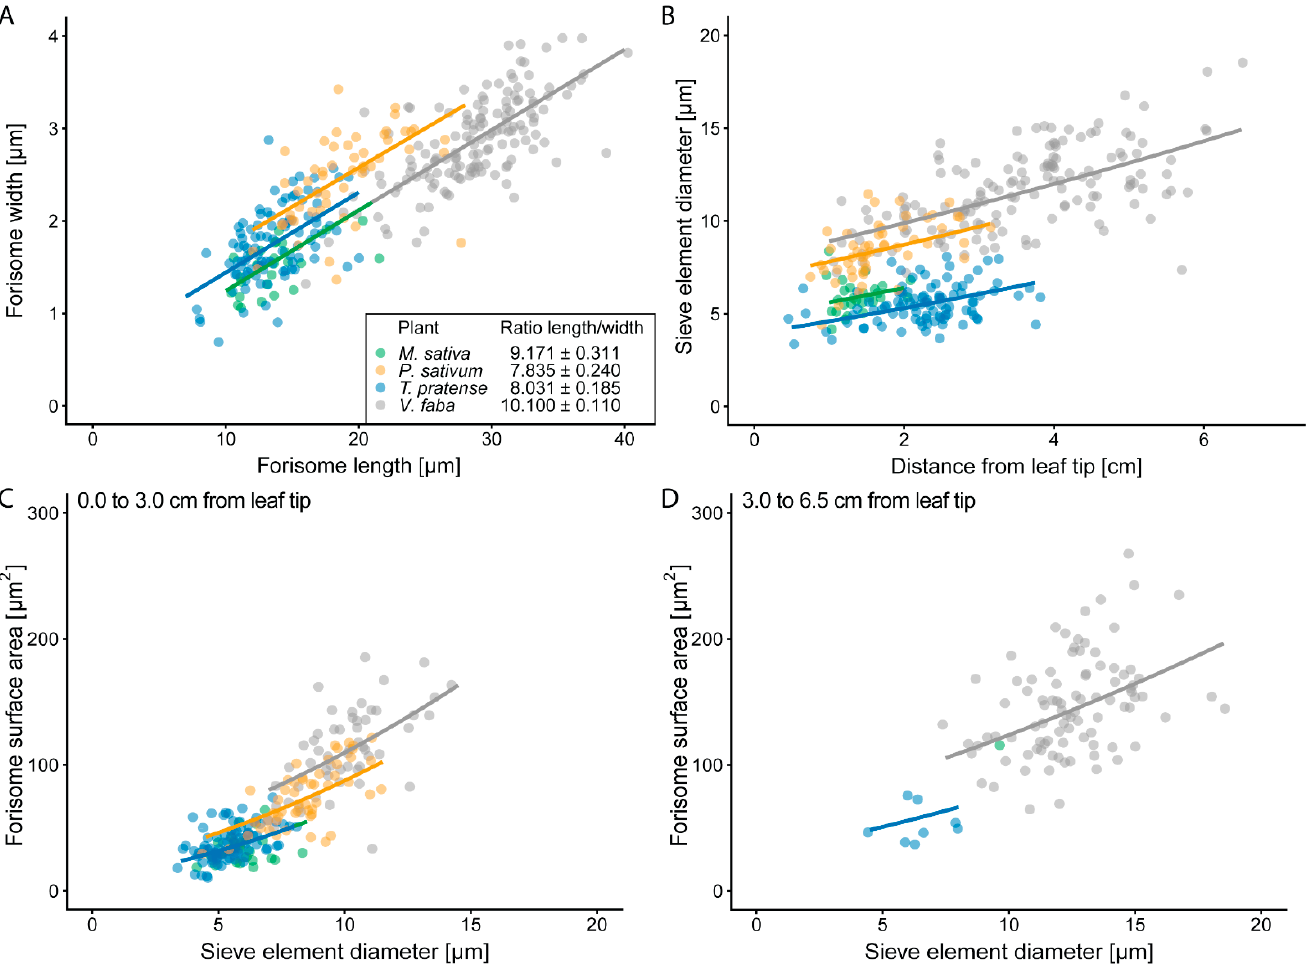
Figure 1. Relationships between sieve element (SE) diameter and forisome dimensions or distance from the leaf tip. ( A ) The relation between forisome width and forisome length and ( B ) between SE diameter and the distance from the leaf tip ( B ) is shown for the investigated legume species. The inset in ( A ) shows the ratio of forisome length to forisome width ± standard error as a numerical presentation of the graphs. ( C , D ) The forisome surface area ( A F ) was calculated based on the forisome width and length and related to the SE diameter. For a better graphical presentation, the relation between forisome surface area and SE diameter is shown for forisomes ( C ) close to (until 3 cm) and ( D ) further away from the leaf tip (3 cm to 6.5 cm). Statistical values are shown in Table S1. Replicates from different plants are presented in: Green— M. sativa ( n = 27), orange— P. sativum ( n = 53), blue— T. pratense ( n = 97), and grey— V. faba ( n = 147).